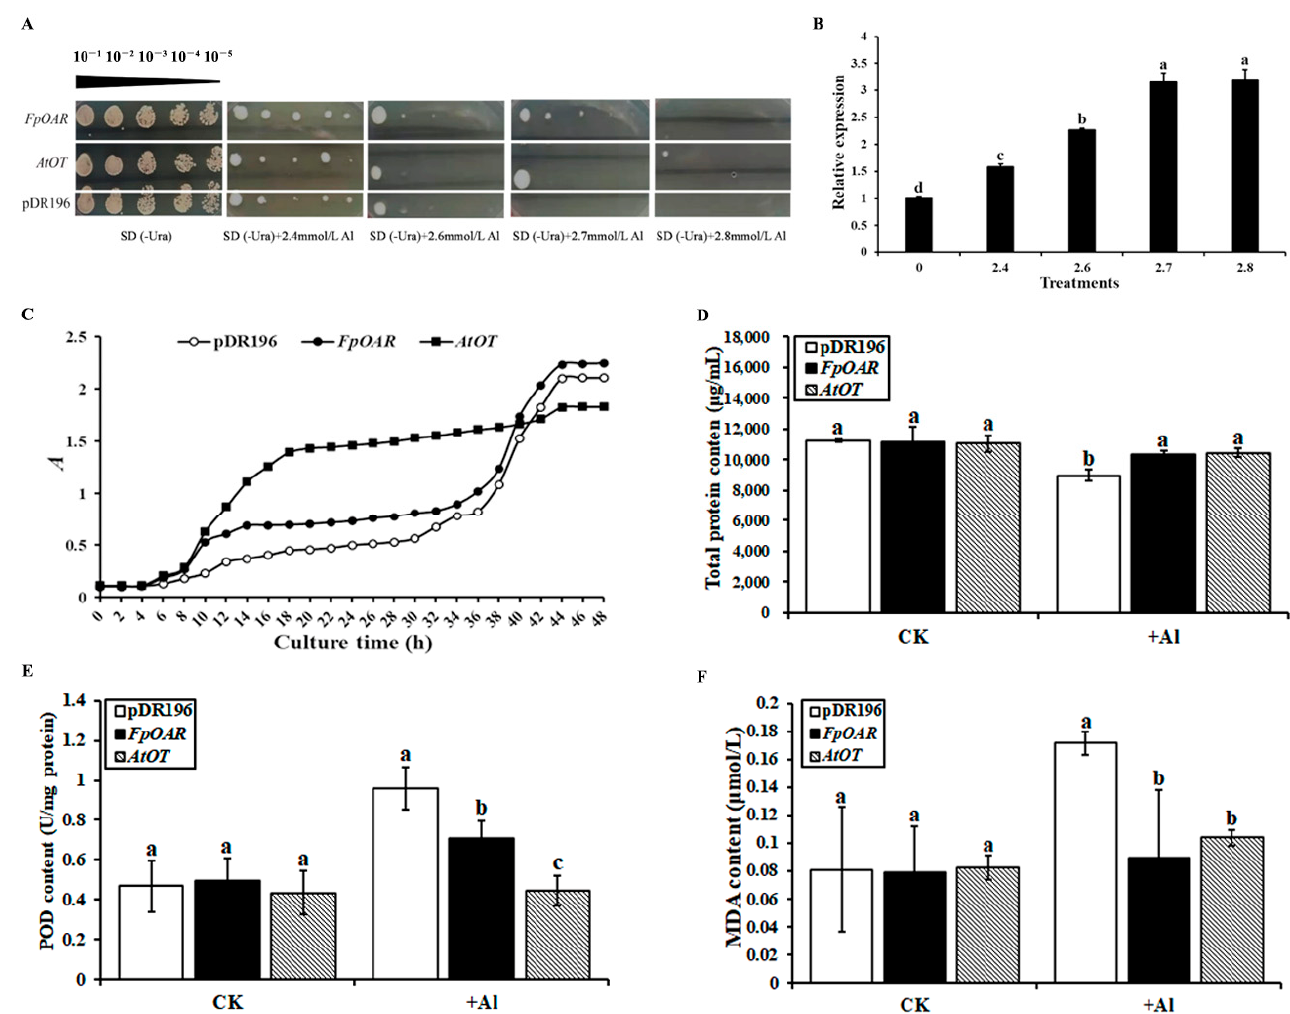
Figure 8. Effects of AtOT on yeast cell aluminum tolerance. ( A ) Effect of AtOT aluminum on yeast cell colony phenotype. ( B ) qRT-PCR analysis of AtOT in the AtOT -recombinant yeast cells under 0 (CK), 2.4, 2.6, 2.7, and 2.8 mM Al 3+ . ( C ) Growth curve of yeast transformants under 2.7 mM Al 3+ stress. ( D ) Determination of total protein content of yeast transformants under 2.7 mM Al 3+ stress for 48 h. ( E ) Determination of malondialdehyde (MDA) content in yeast transformants under 2.7 mM Al 3+ stress for 48 h. ( F ) Determination of peroxidase (POD) content in yeast transformants under 2.7 mM Al 3+ stress for 48 h. Different letters above bars in ( C – E ) indicate significant differences among various recombinant yeast cells at p < 0.05.